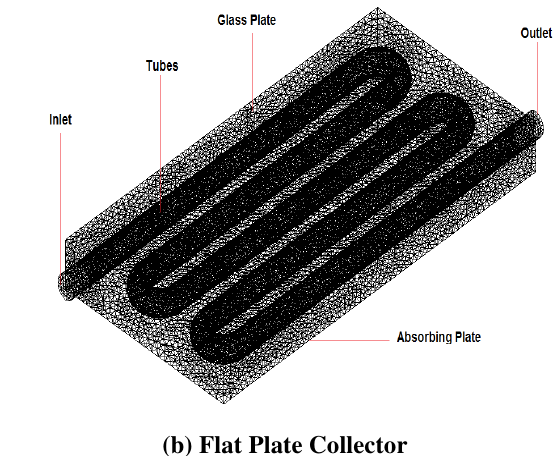
Fig. 1: Computational Domains of Solar Collectors The Computational fluid dynamics numerical